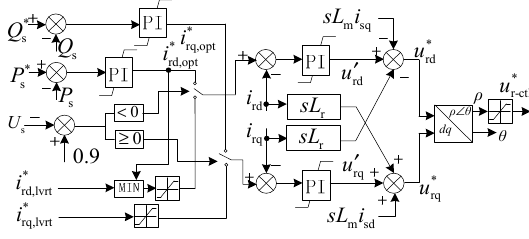
Figure A1. Control diagram of the RSC.